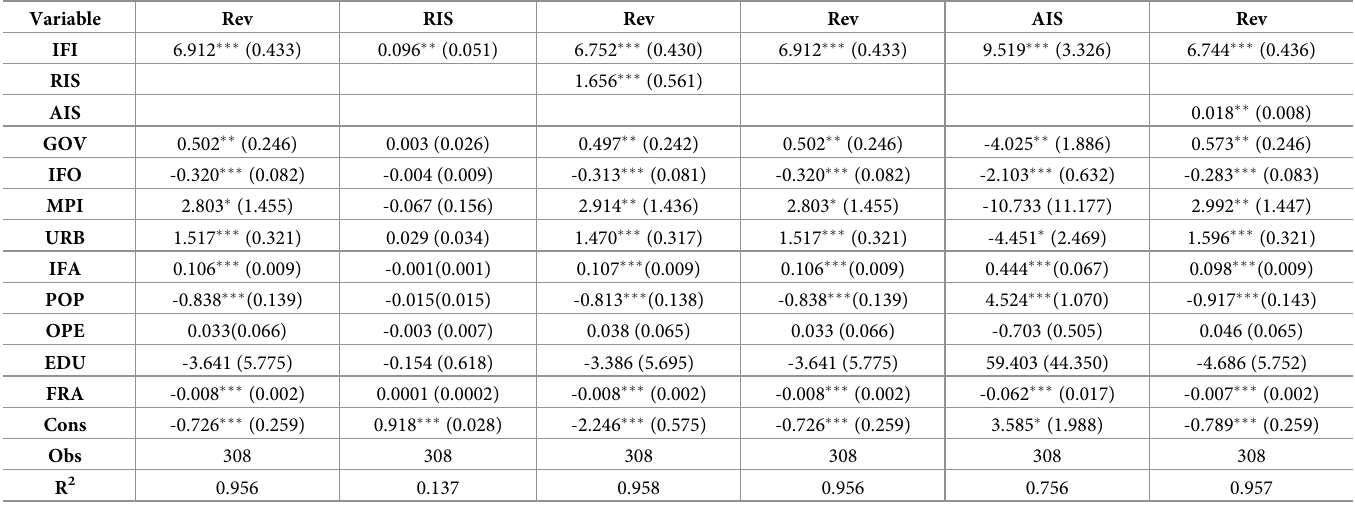
Table 12. Robustness test: Add control variables.